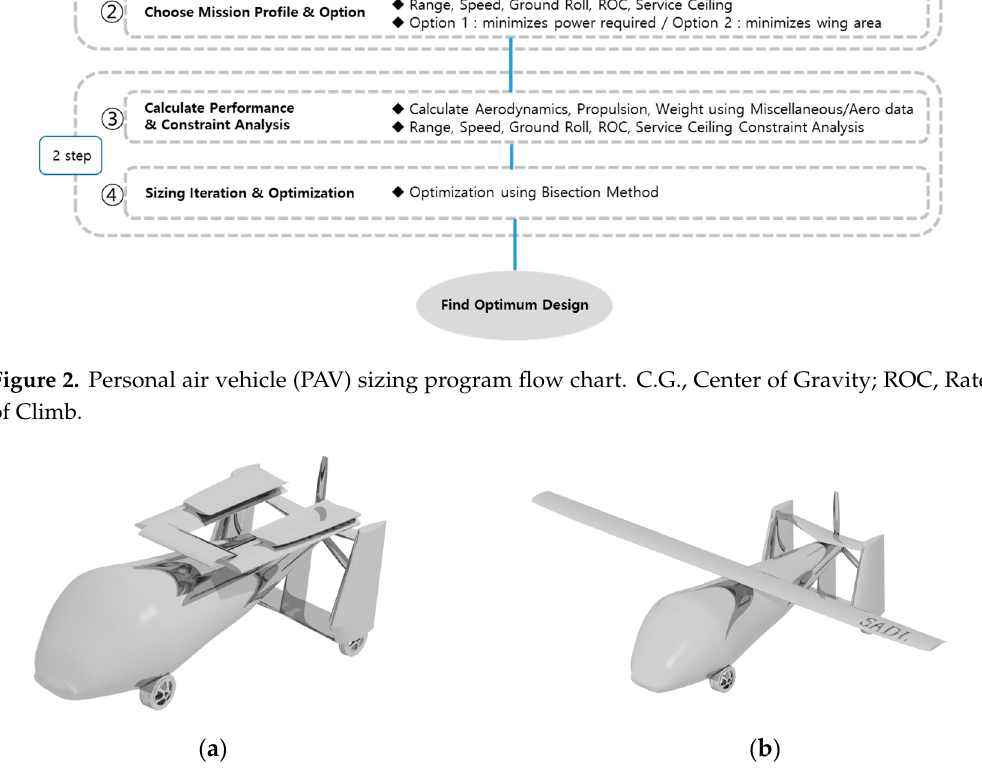
Figure 3. PAV configuration: ( a ) description of drive mode; ( b ) description of flight mode.